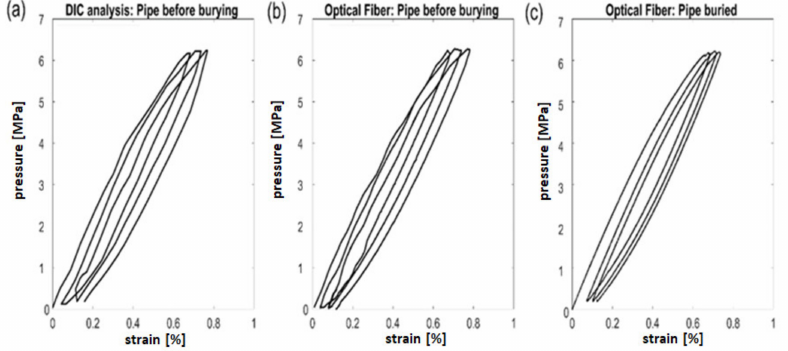
Figure 12. Circumferential strain variation along three cycles of pressurization at the most-strained points in Specimen #20: ( a ) DIC before burying, ( b ) FBSG before burying, ( c ) FBSG after burying.